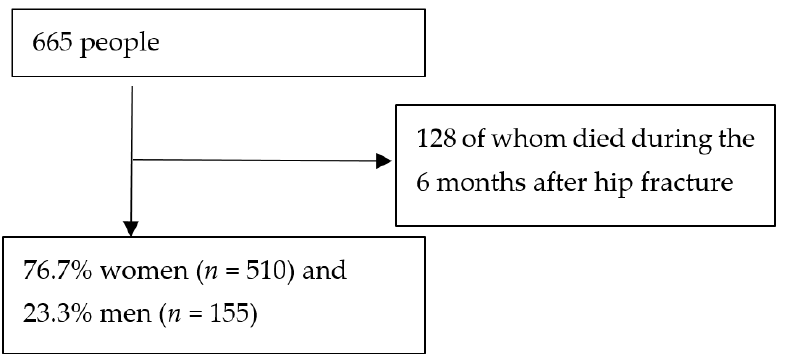
Figure 1. Participants flow.